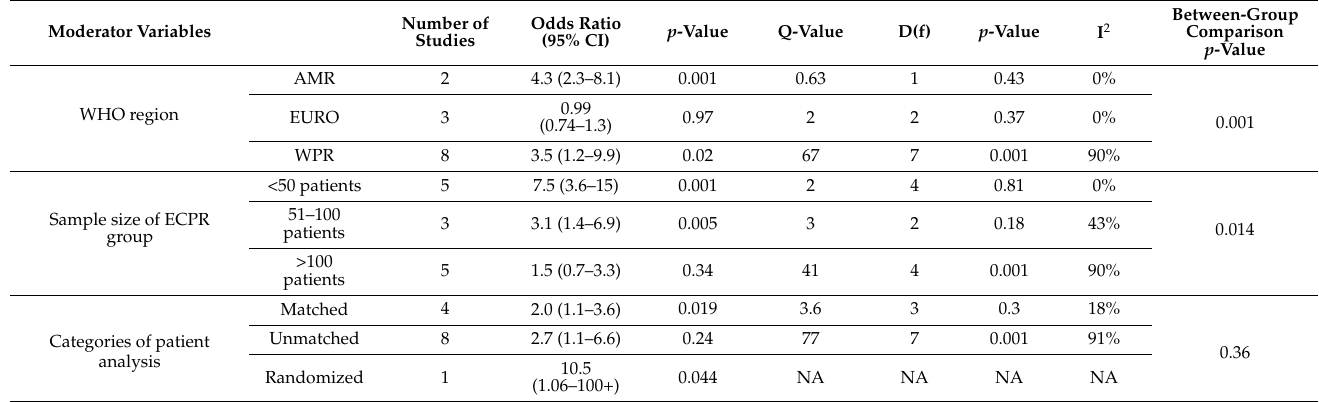
Table 3. Moderator analyses using studies’ characteristics as categorical